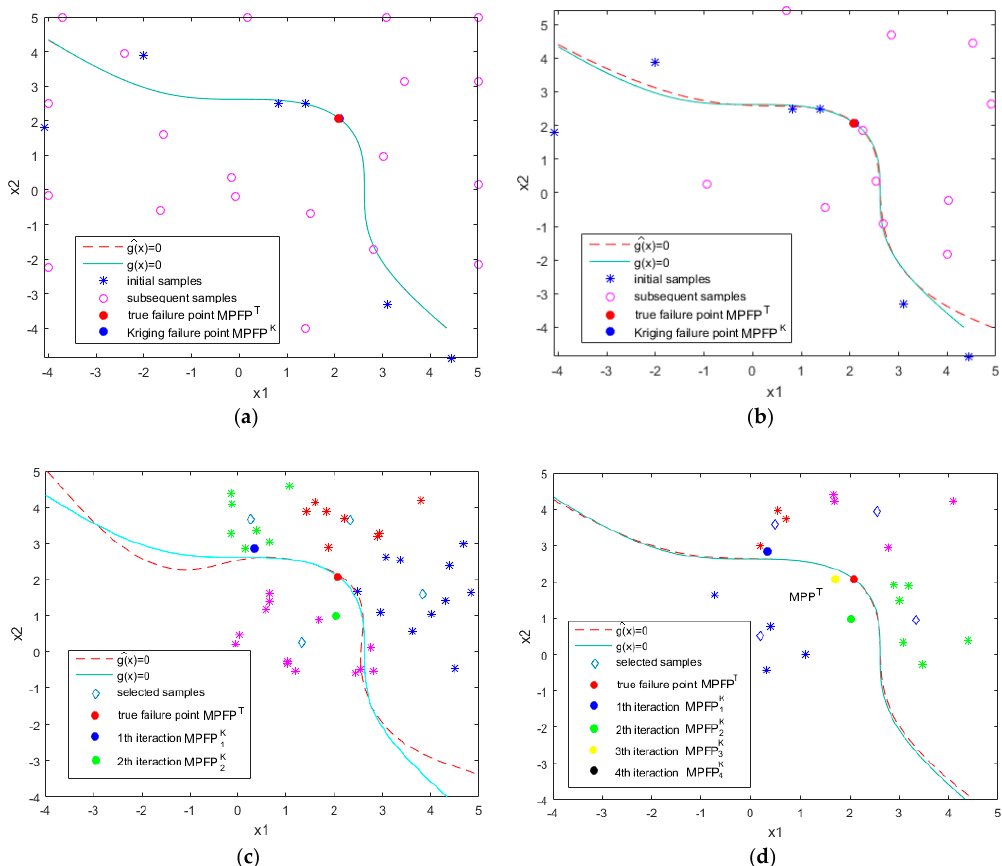
Figure 4. ( a ) The EGRA sampling method; ( b ) the local approximation method; ( c ) result of local approximation and clustering in Iteration 2; ( d ) result of local approximation and clustering in Iteration 4.